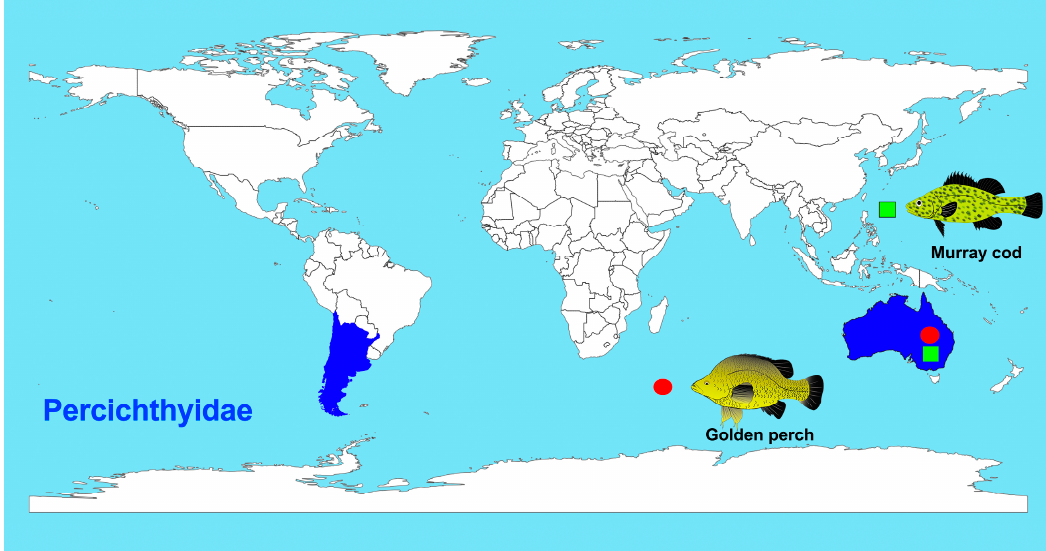
Figure 1 . Distribution of nine genera of Percichthyidae covering Australia, Chile and Argentina Figure 1. Distribution of nine genera of Percichthyidae covering Australia, Chile and